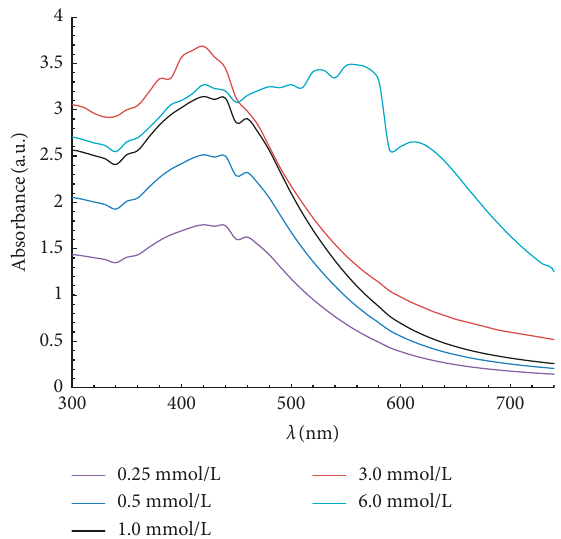
Figure 3: Absorption spectra of obtained colloidal solutions of silver nanoparticles using plasmochemically obtained OrPWE and Ag + concentrations (1–0.25 mmol/L, 2–0.5mmol/L, 3–1.0 mmol/L, 4–3.0mmol/L, and 5–6.0 mmol/L).